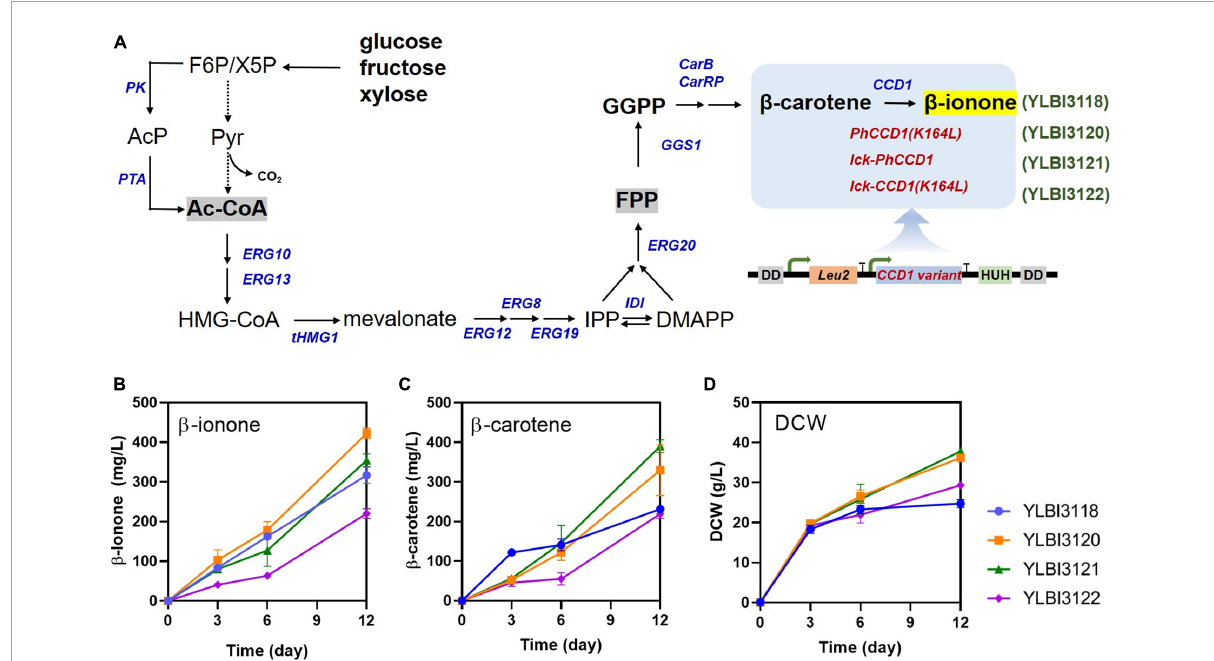
FIGURE1 Metabolic engineering of Y. lipolytica for the highly efficient production of β -ionone. (A) The schematic diagram of the β -ionone biosynthesis pathway in engineered Y. lipolytica . (B) β -ionone, (C) β -carotene, and (D) biomass production (dry cell weight, DCW) at various time-points. Fermentation was conducted in 25 mL of YPDm medium containing 10% (v/v) dodecane. Cultures were incubated with shaking at 250 rpm at 20 ◦ C for 12 days. Each experiment was performed in triplicates. Abbreviations used in panel (A) : PK, phosphoketolase; PTA, phosphotransacetylase; ERG10, acetoacetyl-CoA thiolase; ERG13, hydroxymethylglutaryl-CoA synthase; tHMGR, truncated hydroxymethylglutaryl-CoA reductase; ERG8, phosphomevalonate kinase; ERG12, mevalonate kinase; ERG19, mevalonate diphosphate decarboxylase; IDI, isopentenyl diphosphate isomerase; ERG20, geranyl/farnesyl diphosphate synthase; GGS1, GGPP synthase; carB, phytoene dehydrogenase; carRP, phytoene synthase/lycopene cyclase; CCD1, carotenoid cleavage